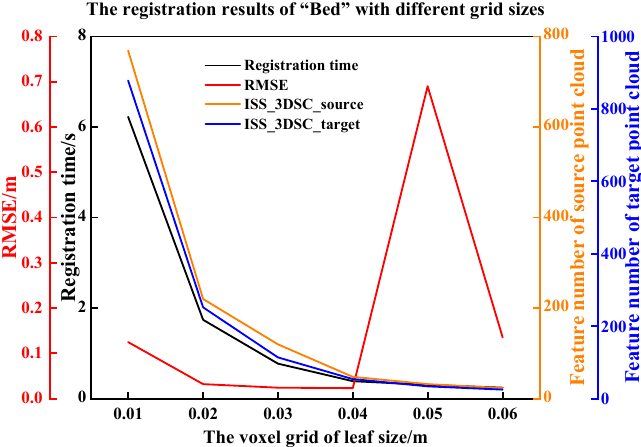
Figure 9. The result of registration under different leaf sizes.